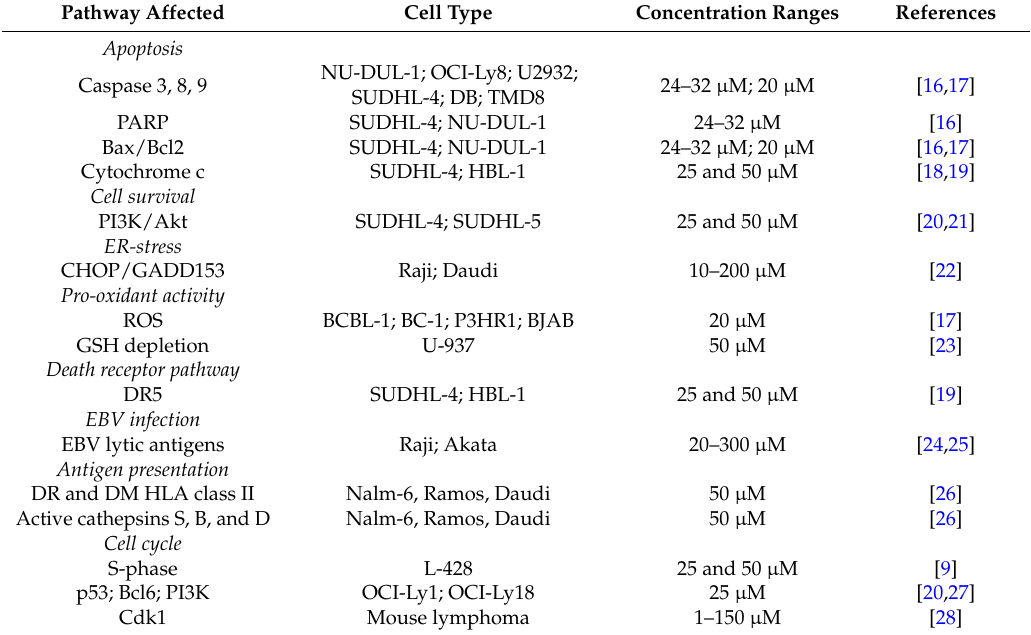
Figure 1. Representation of the main molecular targets demonstrated in lymphoma cells. The blunt-ended arrows represent a downregulating effect. Black, up-oriented arrows indicate up-regulation. Red, down-oriented arrows indicate downregulation. Table 1. Summary of the lymphoma molecular targets cited in the